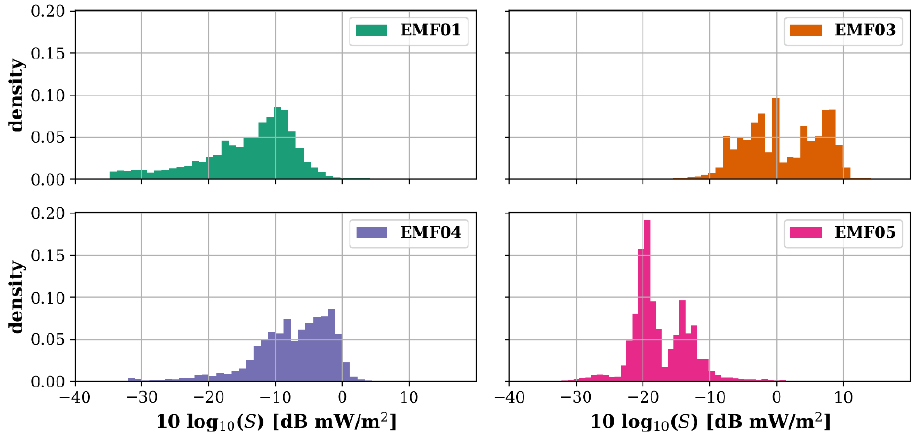
Figure 16. Histograms of the logarithmic power density measured by the mobile RF sensors when applying the free-space calibration antenna apertures.